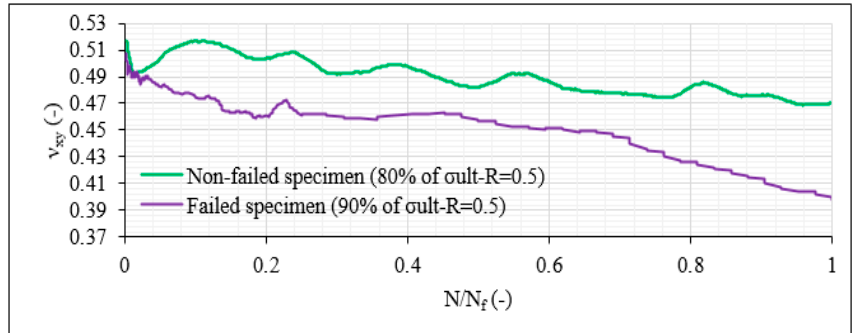
Figure 23. ν xy evolution versus the normalised fatigue life for one nonfailed [0°/30°] 2s laminate ( σ max = 0.8 × σ ult and R = 0.5) and one failed [0°/30°] 2s laminate ( σ max = 0.9 × σ ult and R = 0.5).